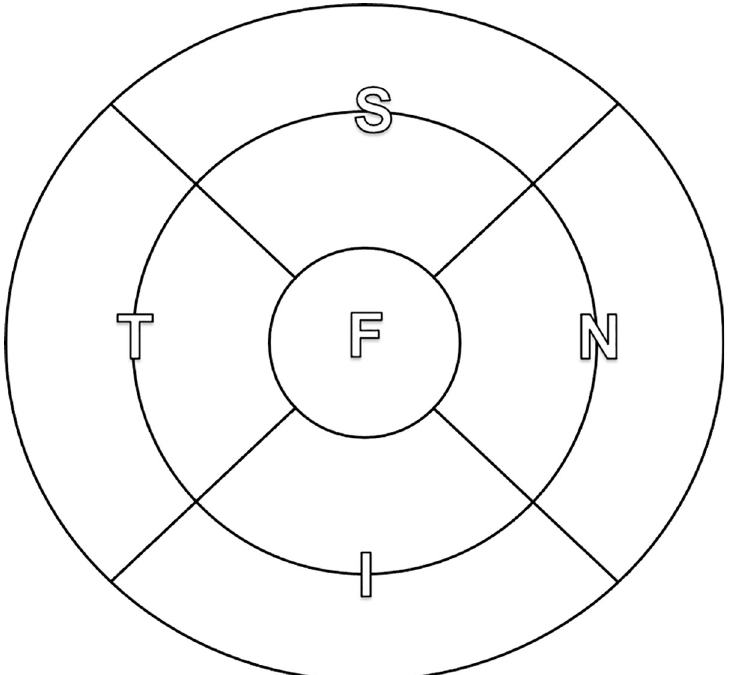
Fig 1. Analysis of the macular region according to the ETDRS map, centered on the fovea (F). The annular region is divided into a 3mm-diameter inner annulus and a 6mm-diameter outer annulus. Each annulus is further divided into superior (S), nasal (N), inferior (I), and temporal (T)